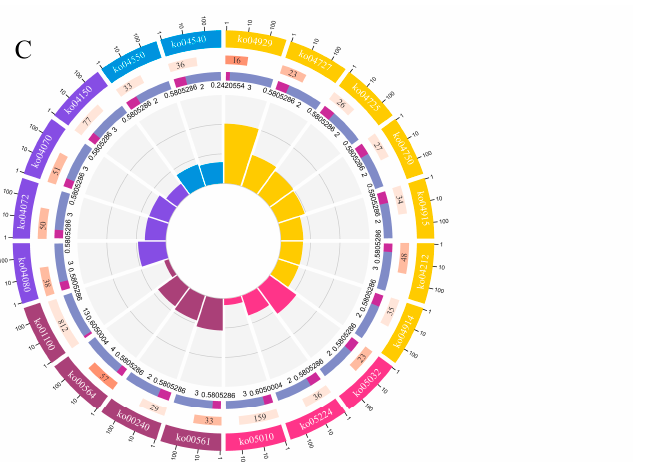
Figure 6. KEGG pathways enriched by targets in the ( A ) AmCK1 vs. AmT1, ( B ) AmCK2 vs. AmT2, and ( C ) AmCK3 vs. AmT3 comparison groups.